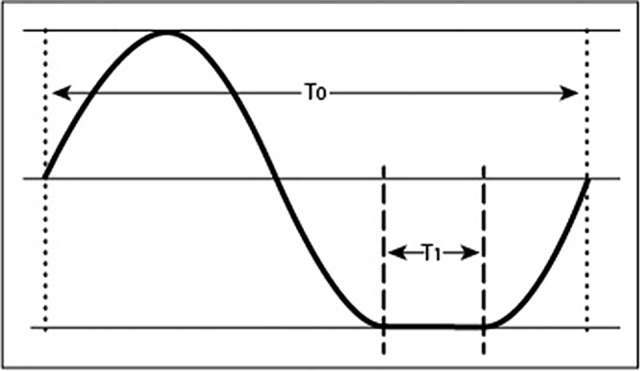
Motion profile of a an object experiencing fractional gravity as a result of non-uniform rotation. The trace of a point rotating around an axis shows an extended resting position during phase T1. The ratio between the dwell time in the bottom position (T1) and complete rotation (T0) corresponds to the fractional gravity experienced by plants, provided that the dwell time does not exceed the gravity perception time.